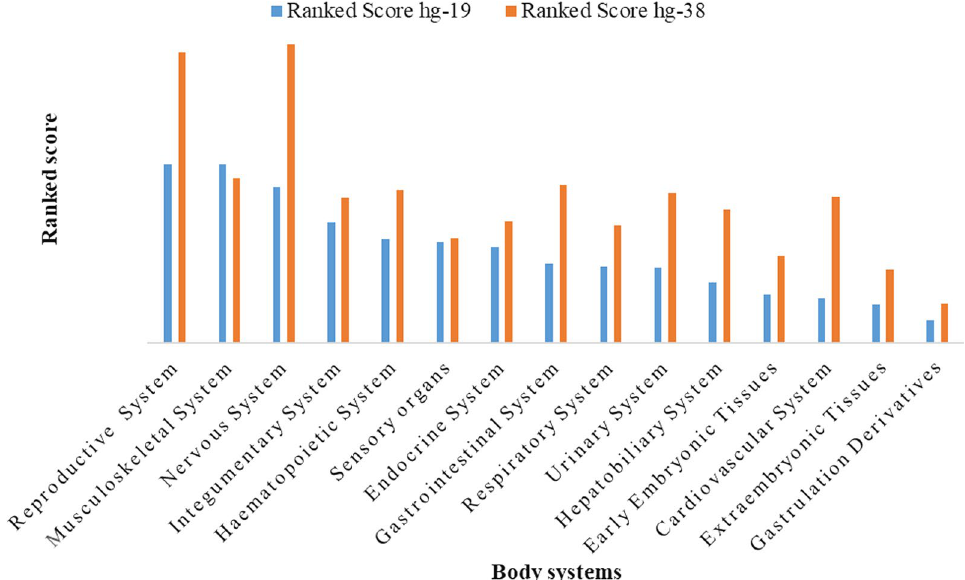
Fig. 1 Genes of Mural and Cumulus Granulosa Cells by Systems of the Body. Genes from Mural and Cumulus Cells are distributed across the many body systems in accordance with their GeneAnalytics rank score. The horizontal axis shows the various bodily systems, and the vertical bar represents the detected genes’ ranking within each system; the colours reflect the hg-19 and hg-38